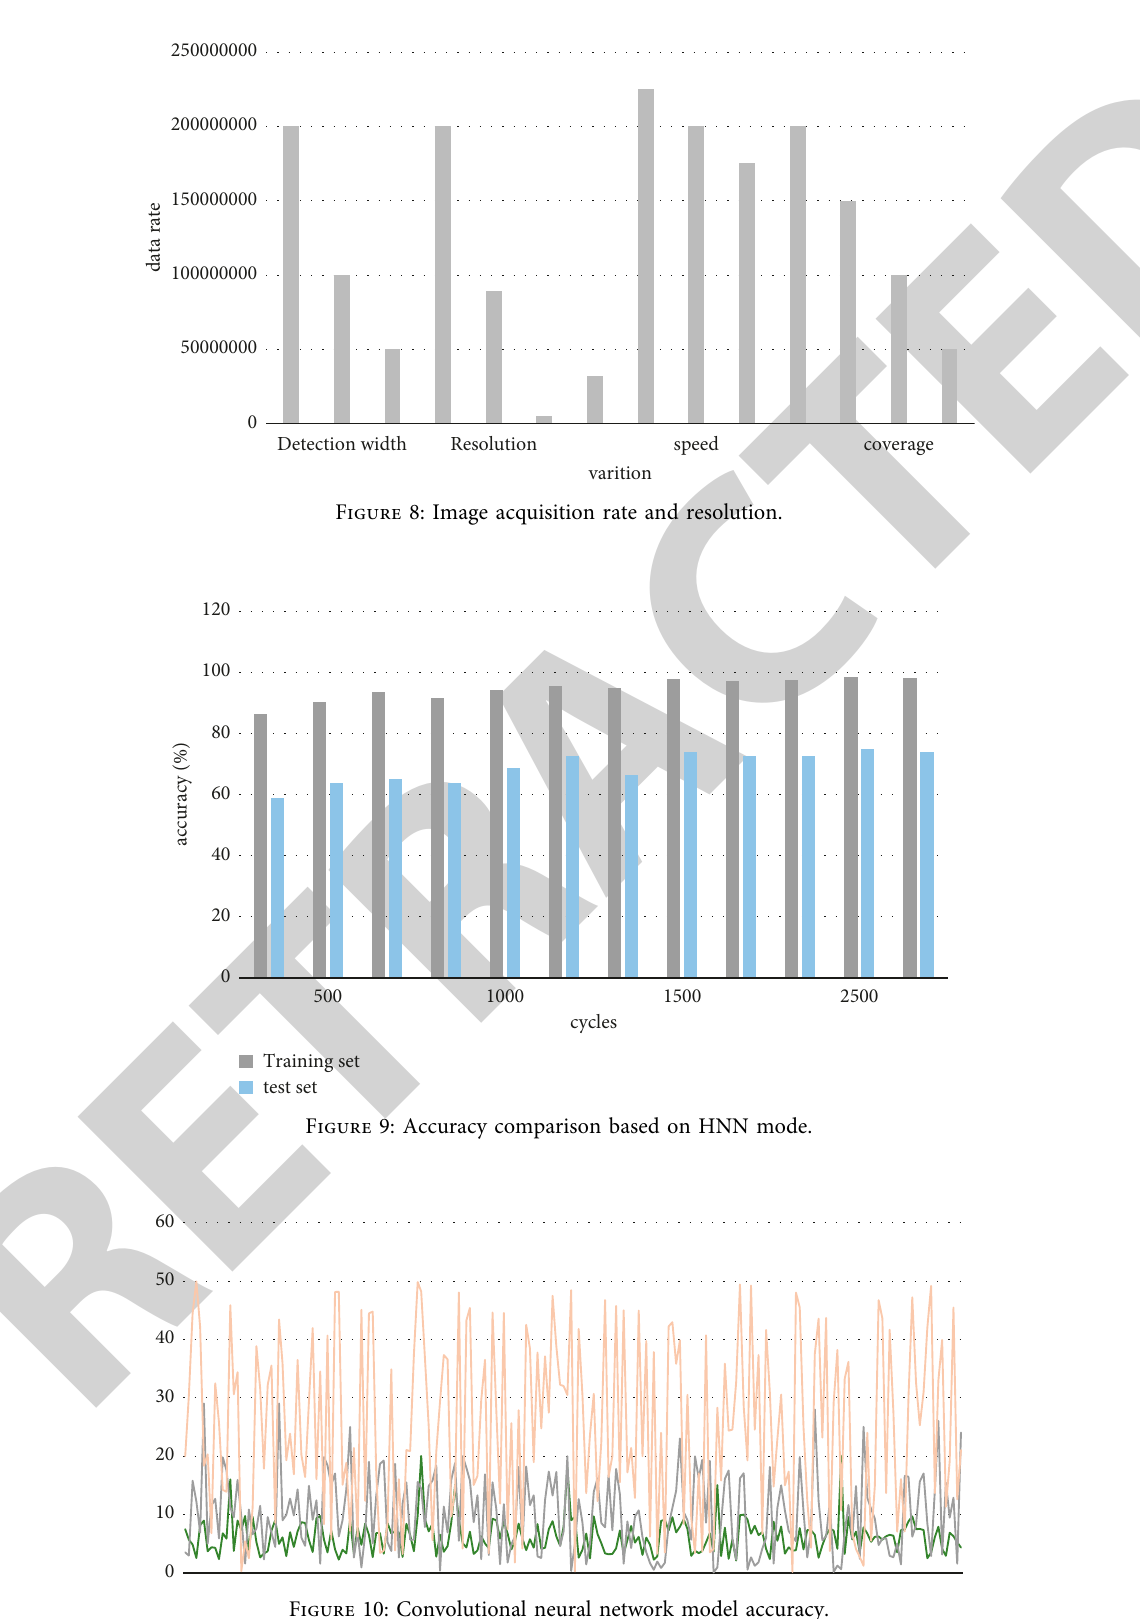
Figure 10: Convolutional neural network model